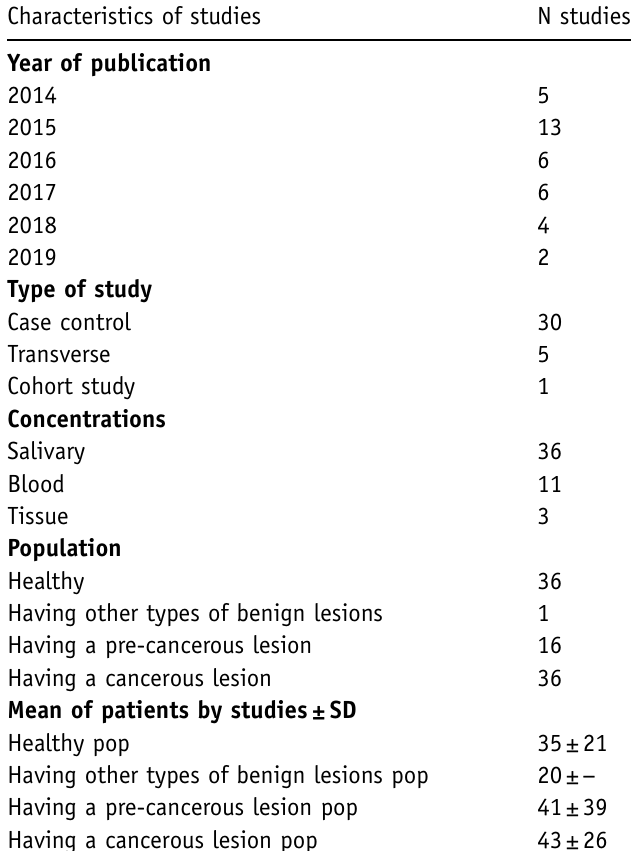
Table I. Summary of characteristics of included